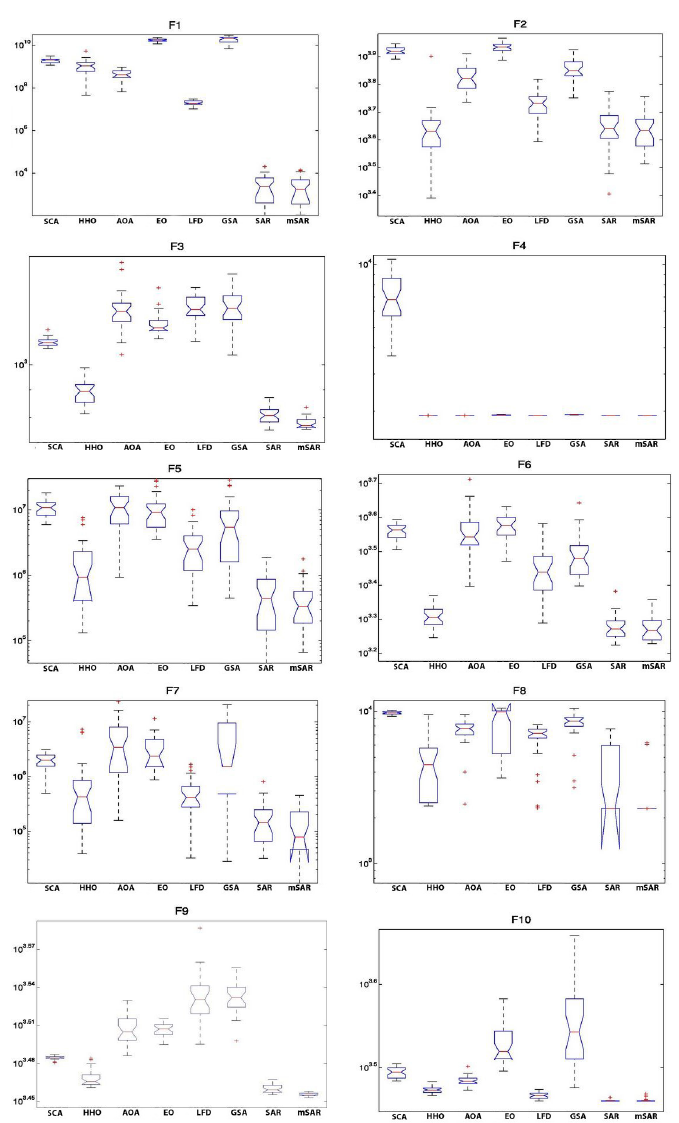
Figure 4. The outcomes of the boxplot of the proposed mSAR algorithm with other competitive algorithms over CEC’2020 functions with D =